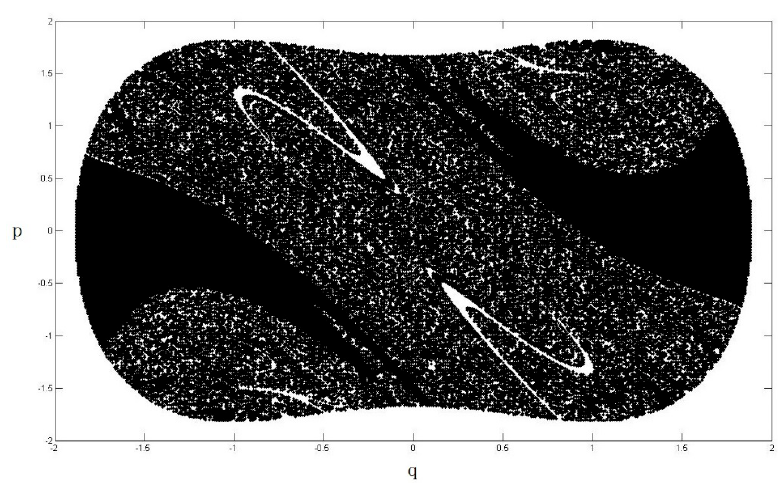
Figure 5. Safe basin of the system when e = 0.4. Nanomaterials 2018 , 8 , x FOR PEER REVIEW